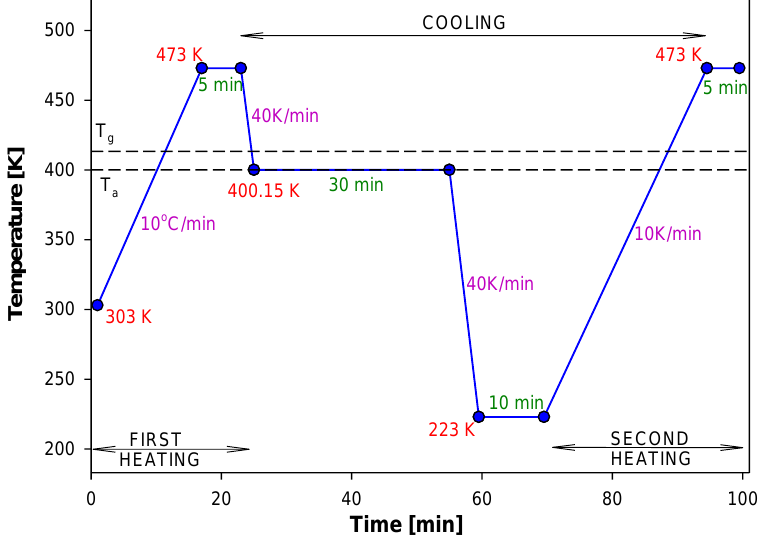
Figure 18. Example of the isothermal aging program during a measurement by DSC.